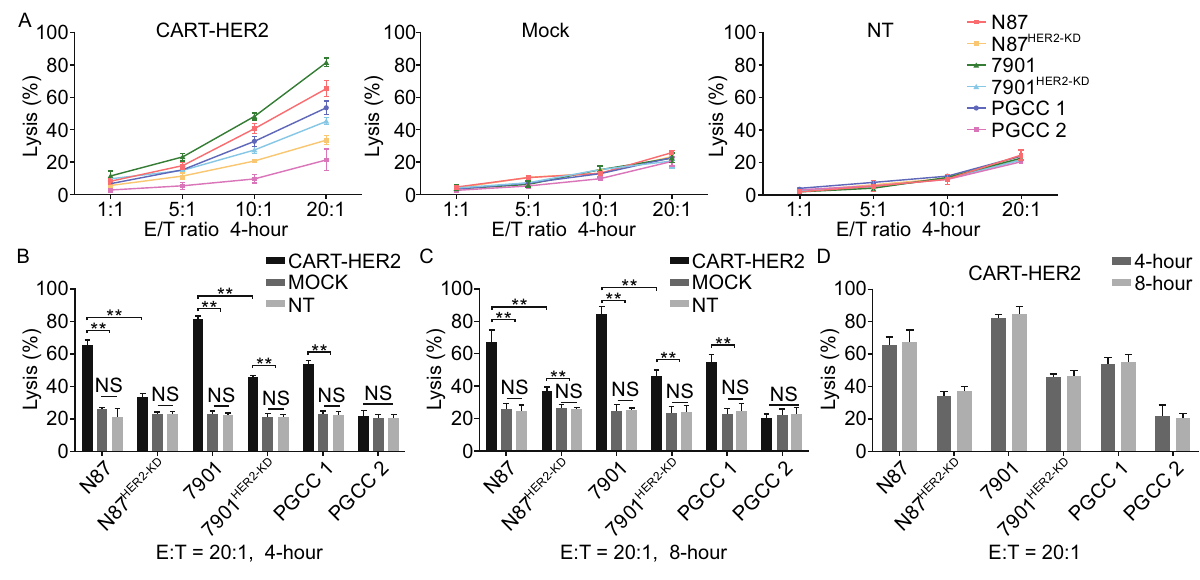
Figure 3. Speci fi c cytotoxicity exhibited by HER2-directed chimeric antigen receptor T cells against HER2 + GC cell line and primary GC cells ex vivo . (A) The cytotoxic activity of CART-HER2, mock T, and NT Tcells against HER2 high+ and HER2 KD GC cells was determined using a 4-h lactate dehydrogenase (LDH) release assay in a dose-dependent manner. HER2 − primary GC cells were used as controls. (B) A 4-h LDH release assay, at an effector-to-target (E/T) ratio of 20:1, was used to compare cytotoxicity between CART-HER2, mock T, and NT T cells against different GC cells (C) An 8-h LDH release assay, at an E/T ratio of 20:1, was used to compare cytotoxicity between CART-HER2, mock T, and NT Tcells against different GC cells. (D) Cytotoxicity comparisons of CART- HER2 cells against different GC cells were performed between the 4-h and 8-h LDH release assays at an E/T ratio of 20:1. All of the results are expressed as the mean of triplicate values ± SD. NS represents no statistical signi fi cance, **represents P